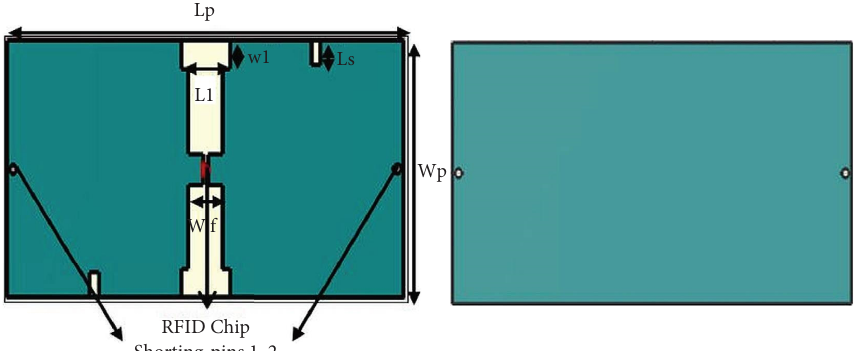
Figure 3: Patch based dipole tag antenna